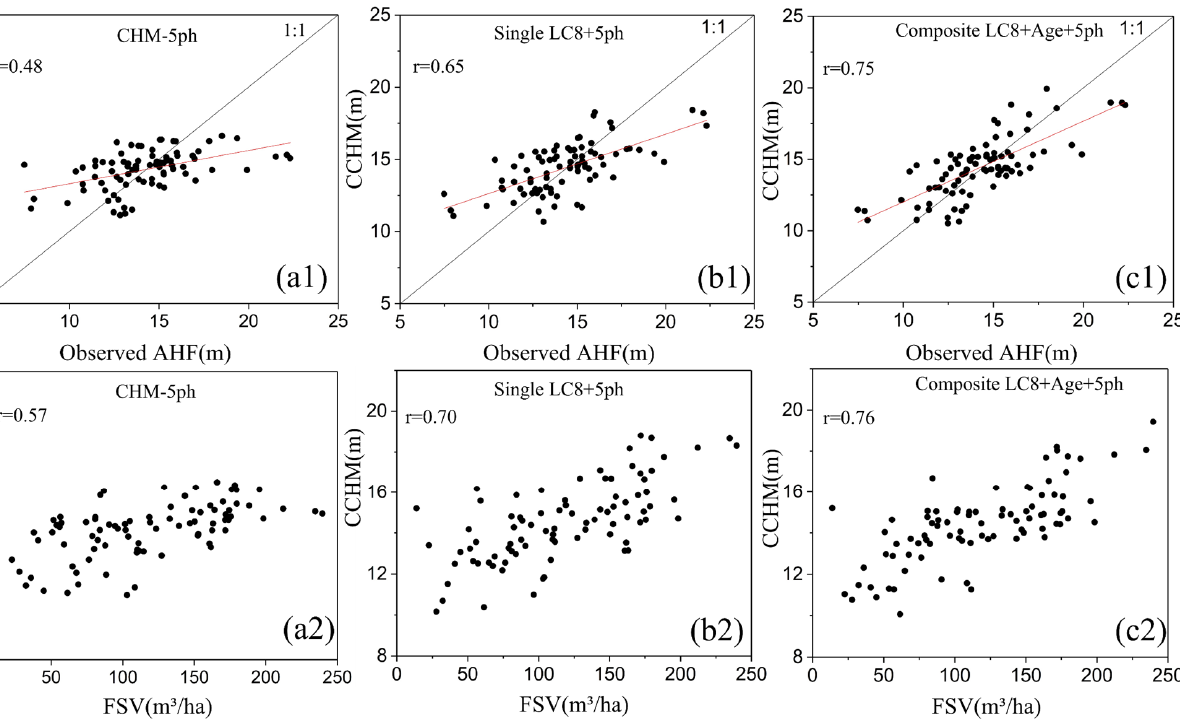
Figure 9. The mapped CCHM of the study area: ( a ) is from single LC8 images and ( b ) is from com- posite LC8 images.